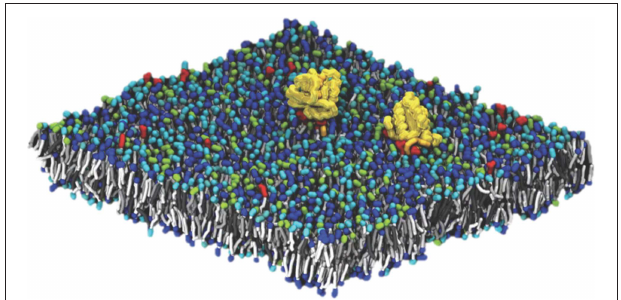
FIGURE 2 | CGMD simulation captures the molecular details of RAS in complex lipid membranes.